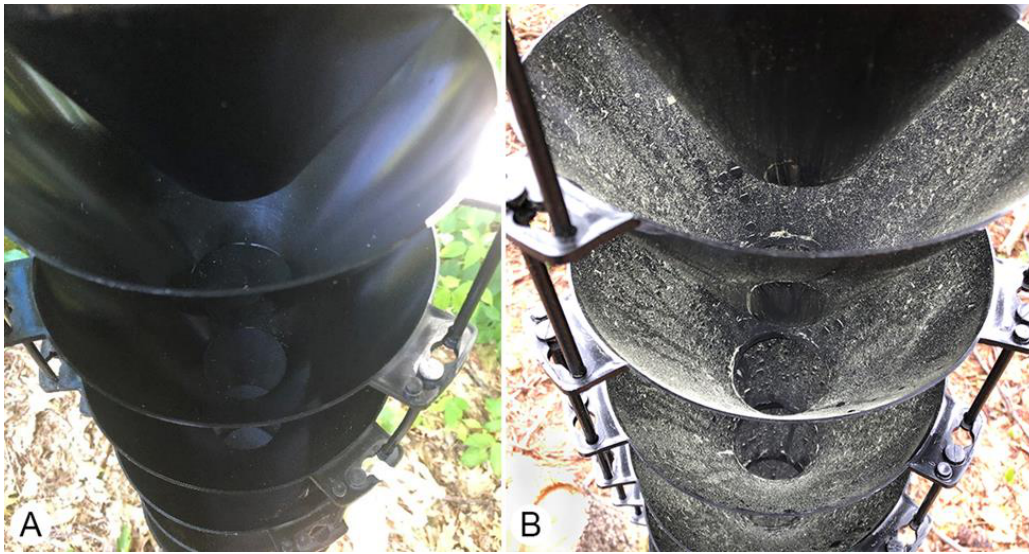
Figure 1. Example of multiple-funnel trap treatments from Experiment 1 in a mixed conifer stand in southeastern New Hampshire. ( A ) Clean trap without surfactant switched out biweekly with a clean trap; ( B ) Control trap without surfactant after six weeks in the field (not shown: two additional treatments of surfactant-treated clean trap and surfactant-treated control trap).